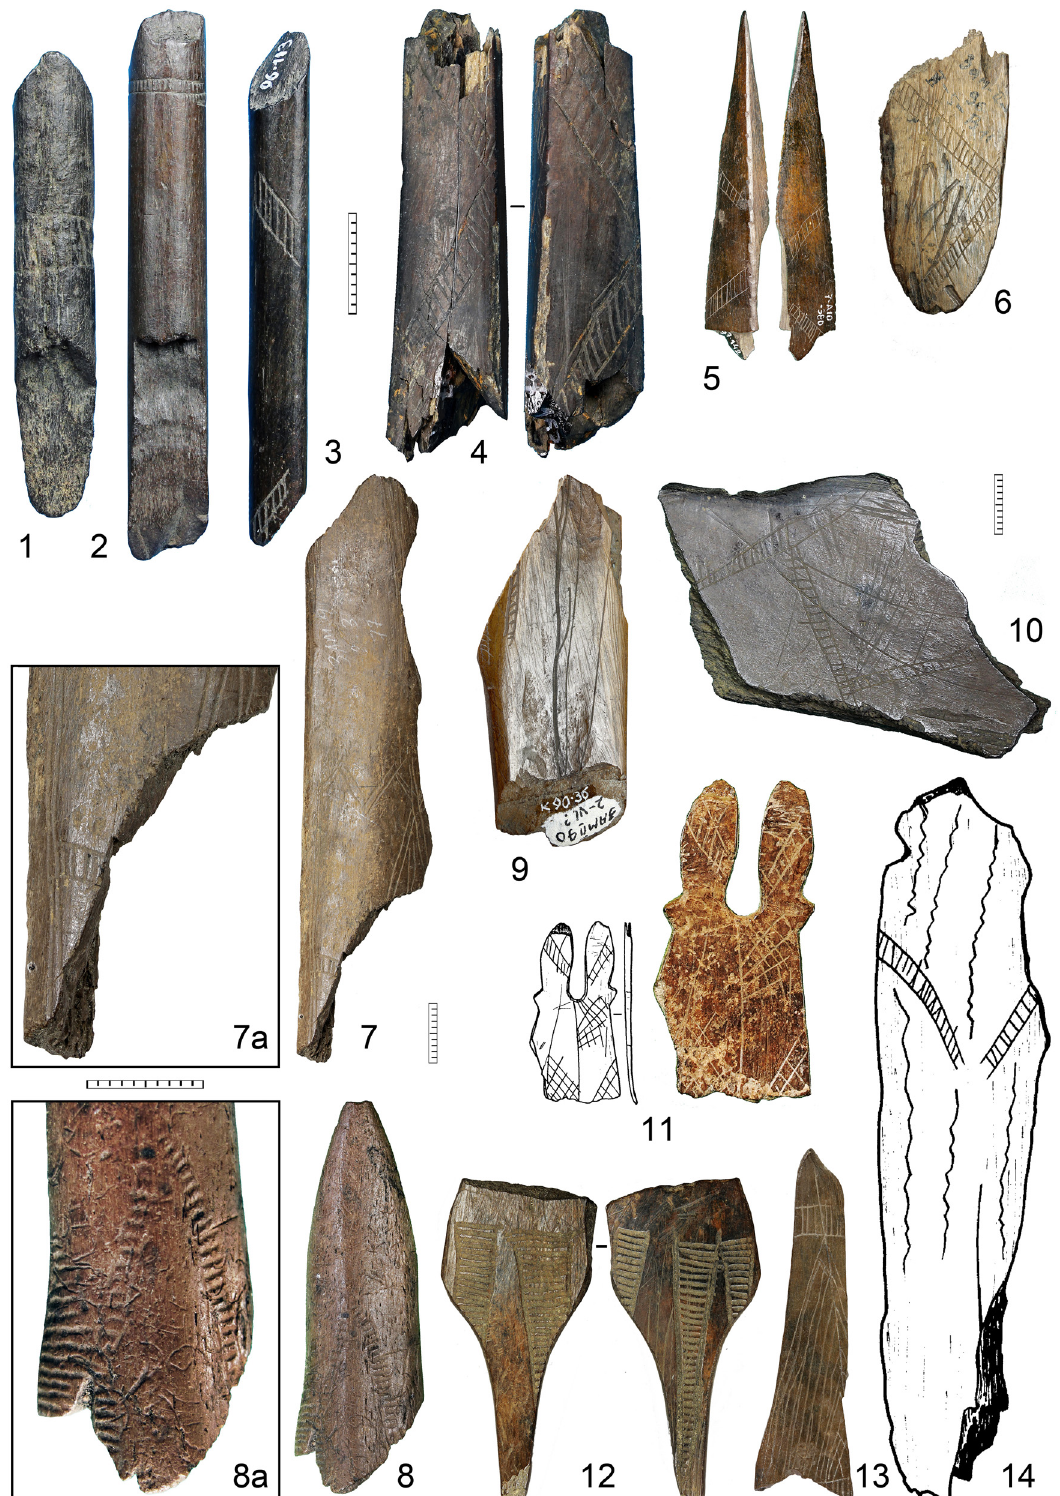
Figure 8: Zamostje 2. ( 1 – 5, 8, 8a ) Arrowheads and spear points; ( 6 – 7, 7a, 9, 12 – 13 ) tool fragments; ( 10 – 11, 14 ) scapula and elk rib knives. Late Mesolithic ( 1 – 6, 9 – 14 ) . Early Neolithic 7, 7a, 8, 8a. Figures 11 and 14 by V.